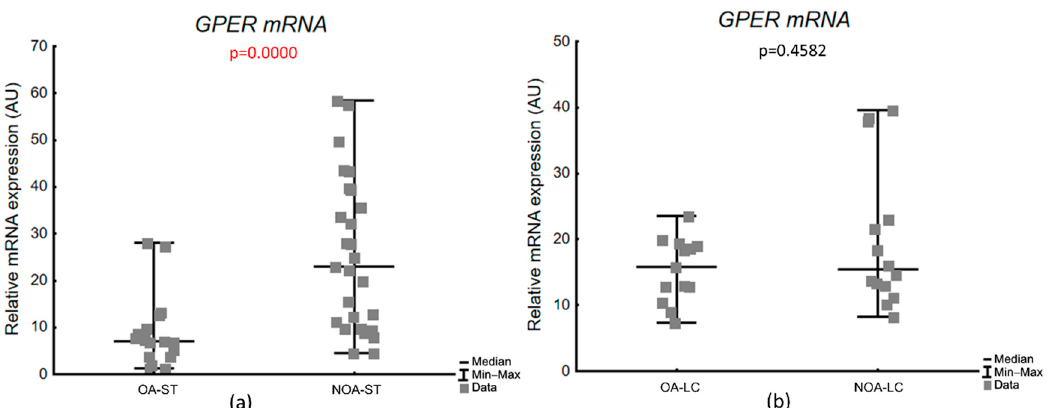
Figure 3. GPER transcriptional level in the laser-microdissected testicular compartments: ( a ) laser- microdissected seminiferous tubules (ST); ( b ) laser-microdissected Leydig cell clusters (LC). AU— arbitrary units (relative quantification normalized to the reference gene RPS29 using the Δ Ct method); p value—Mann–Whitney test.